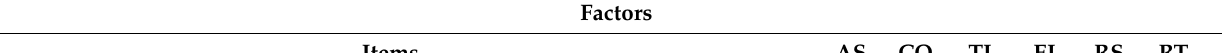
Table 1. Factor loadings (standardized beta weights) stemming from CFA of the